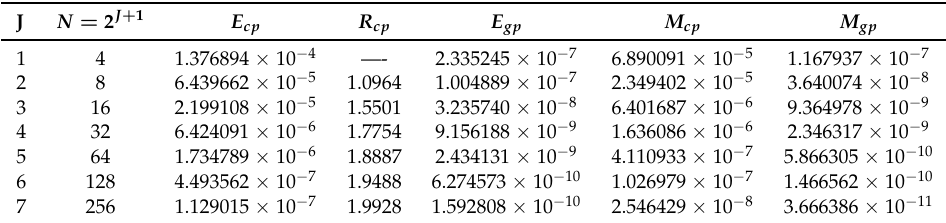
Figure 5. Comparison of numerical and analytical solutions for 32 CPs of Problem 5. Table 6. E cp , R cp , E gp , M cp and M gp for Problem